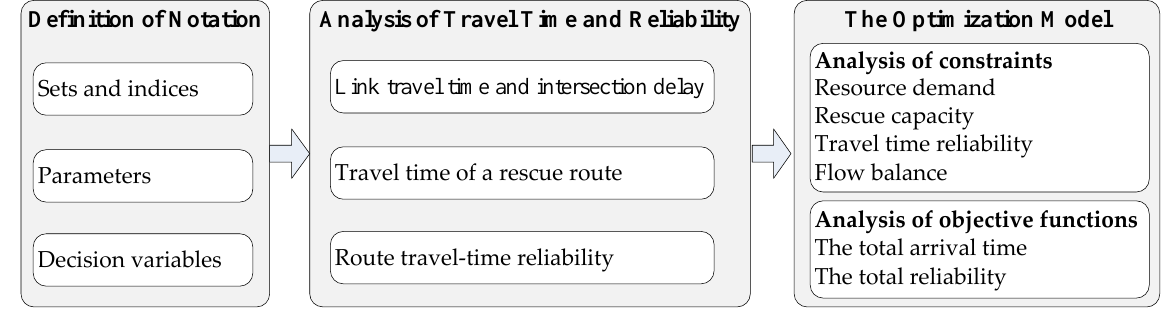
Figure 1. The flow chart of Section 2.